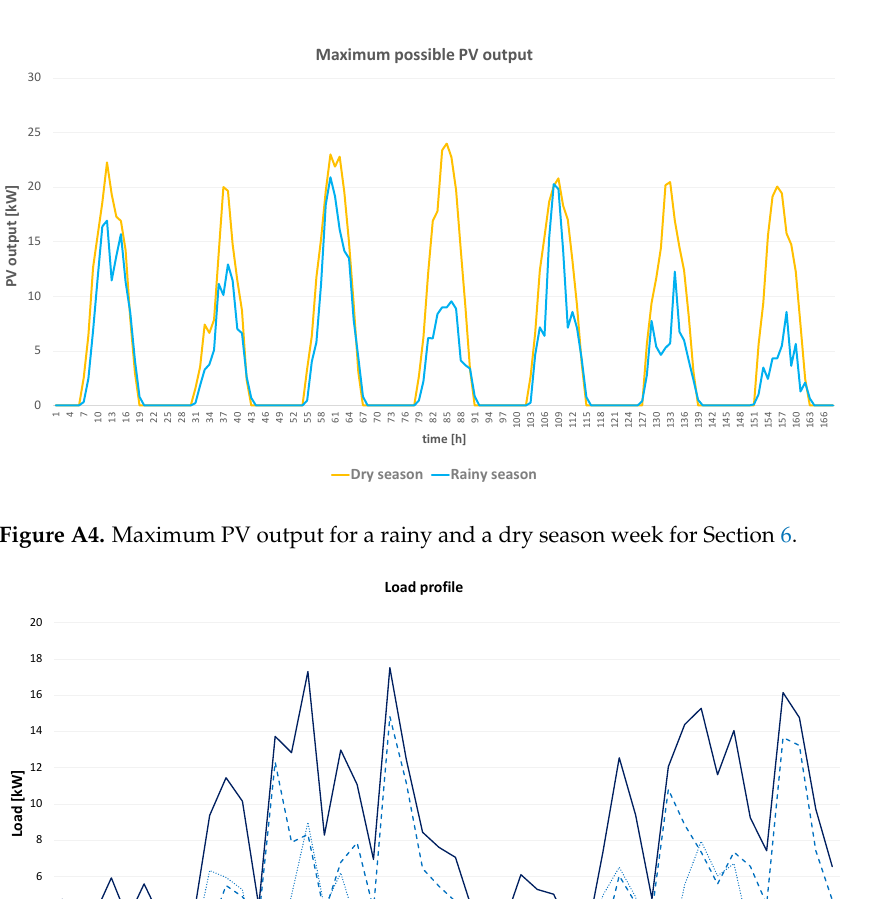
Figure A3. Optimal dispatch for dry season off-grid mini-grid with extra reliability constraint of 65% for Customer B.